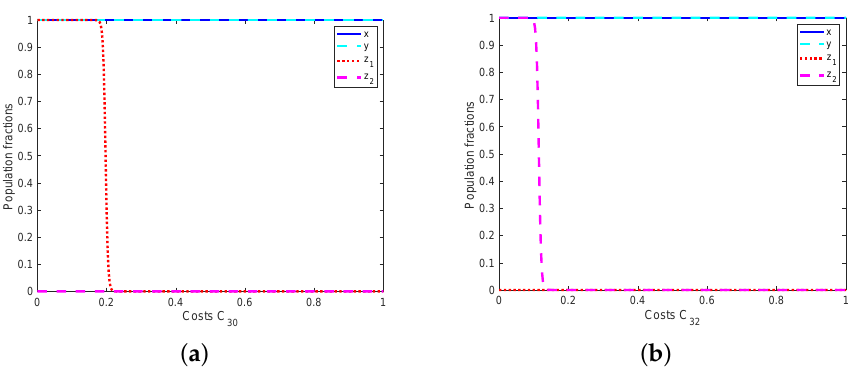
Figure 8. The impact of operation costs of cyberattacks on the ESS E 6 . ( a ) Evolution of population fractions x , y , z 1 , and z 2 over C 30 . ( b ) Evolution of population fractions x , y , z 1 , and z 2 over C 32